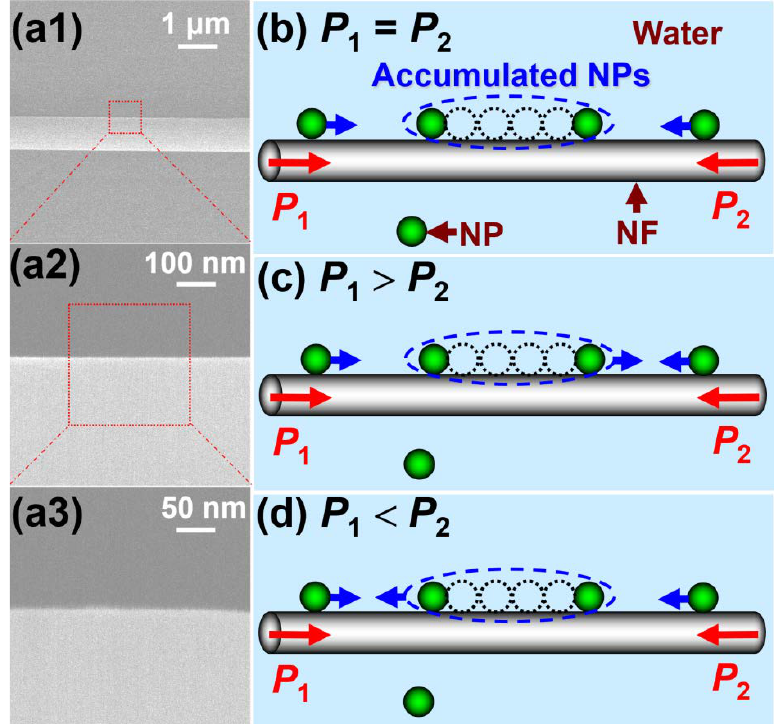
Figure 1. Scanning electron microscope (SEM) image of the nanofiber and schematic of accumulation and delivery of nanoparticles (NPs) along a nanofiber (NF). ( a1 − a3 ) SEM images of the nanofiber with magnifications of 10,000 ( a1 ), 100,000 ( a2 ) and 200,000 ( a3 ). ( b ) When P 1 = P 2 , the accumulated NPs will keep stationary on the NF. When P 1 < P 2 and P 1 > P 2 , the accumulated NPs will be delivered to the right ( c ) and left ( d ) side of the NF, respectively.